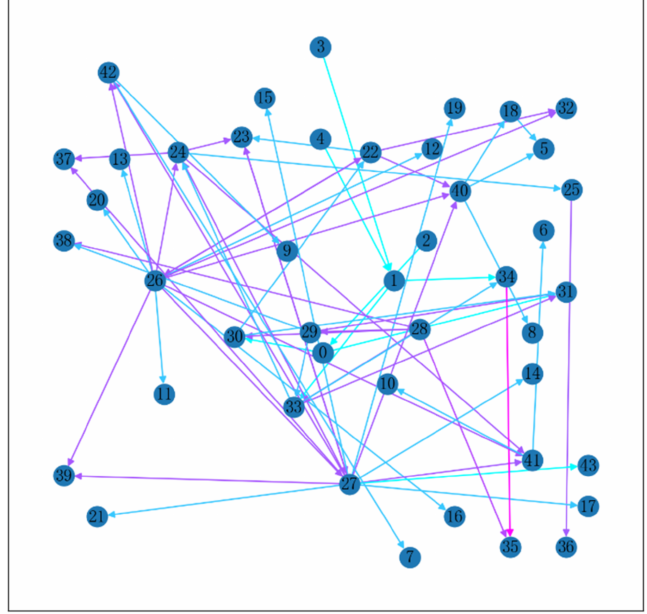
Figure 9. Assembly error network simulated by the probability propagation model (the closer the edge color is to blue, the smaller the weight, and the closer the edge color is to purple, the larger the